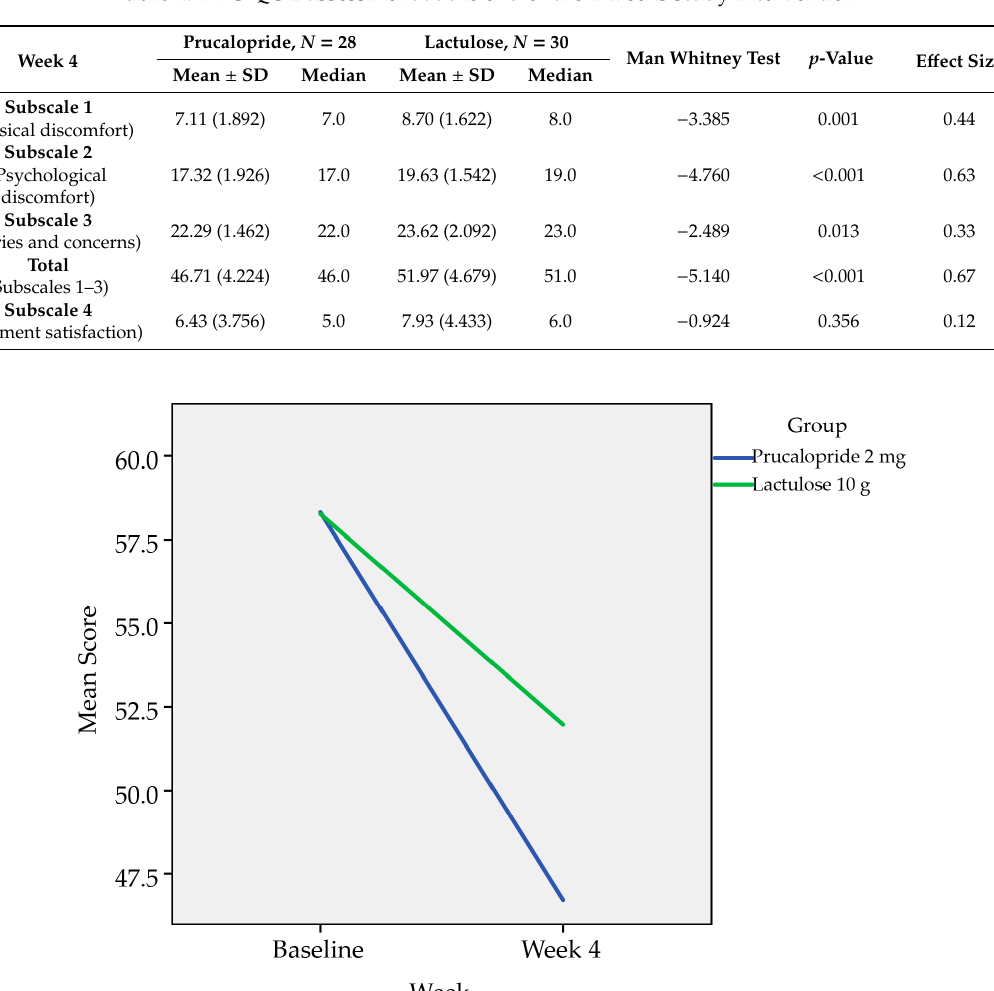
Table 4. PAC-QOL assessment at the end of the 4 weeks study intervention.